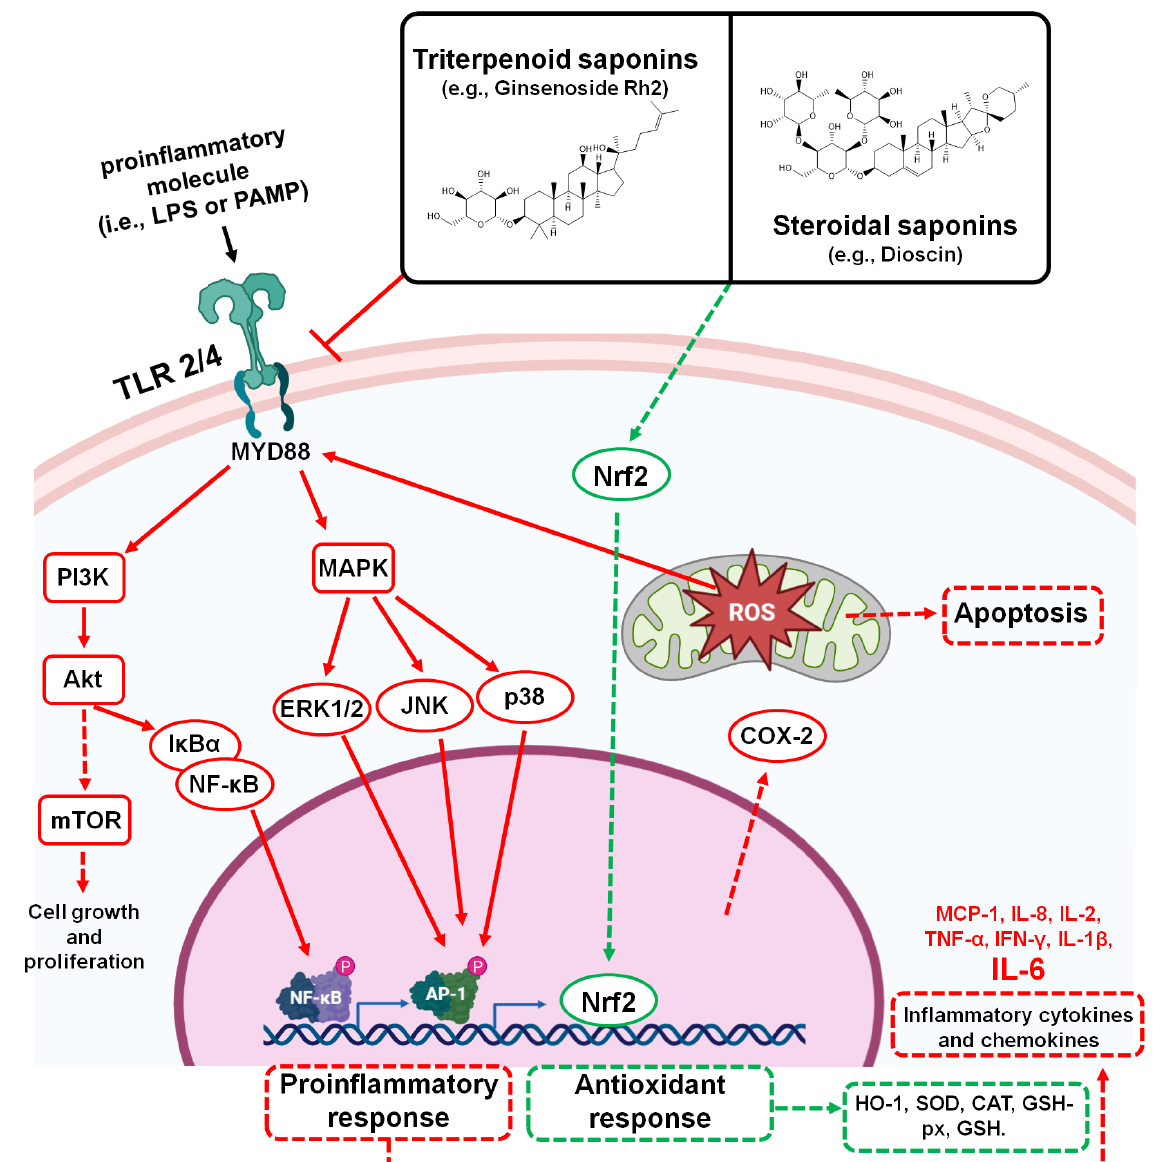
Figure 4. Main anti-inflammatory mechanisms of action of saponins in models of pulmonary in- flammation. Both triterpene (e.g., Ginsenoside Rh2) and steroidal saponins (e.g., Dioscin) have been shown to reduce histopathological changes associated with inflammation in lung tissue by inhibiting the expression (mRNA and protein) and secretion of proinflammatory cytokines (TNF- α , TGF- β 1R, IL-1b, IL-6 and IL-8) and increased expression of anti-inflammatory cytokines (TGF- β 1 and IL-10). According to Passos et al. [26], Hsieh et al., [81], and Wang, et al., [104] the anti-inflammatory molecular mechanism of saponins commonly described for pulmonary inflammatory models in- volves the inactivation of the TLR2 and TLR4 signaling and expression pathway, since either inhi- bition of the TLR4/MYD88/PI3K/Akt signaling pathway or the TLR2/MYD88/MAPK pathway, thereby inhibiting the activation of NF- κB and AP -1, and consequently inhibiting gene expression associated with proinflammatory (proinflammatory enzymes and cytokines) and apoptotic re- sponses. On the other hand, triterpene and steroidal saponins positively regulate the Nrf2 signaling pathways, promoting the expression of antioxidant genes, causing the expression of antioxidant enzymes and molecules (HO-1, SOD, CAT, GSH-px, GSH), decreasing cell death associated with oxidative stress by the inflammatory process. Red boxes and arrows indicate inhibition; Green boxes and arrows indicate stimulation.